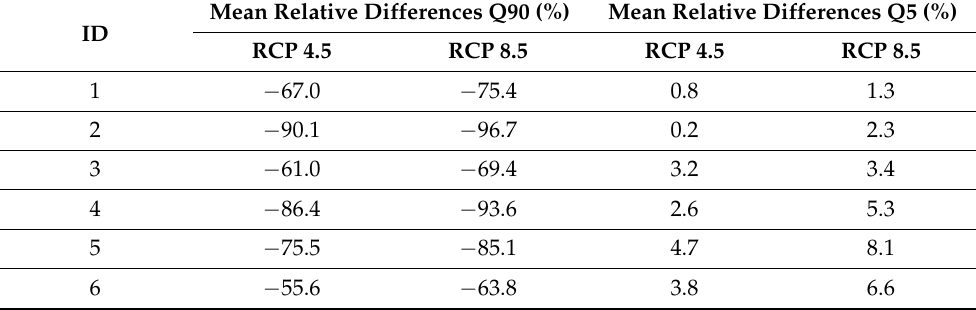
Table 6. Mean relative differences in Q90 and Q5 between the future and reference periods and both